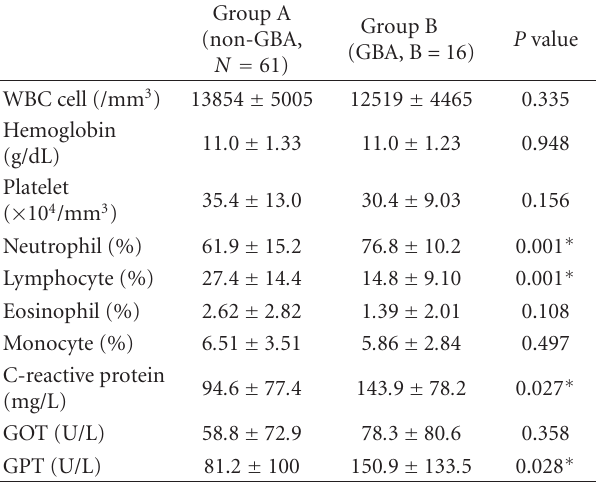
Table 4: Comparison of lab data between GBA and non-GBA in Kawasaki disease after IVIG